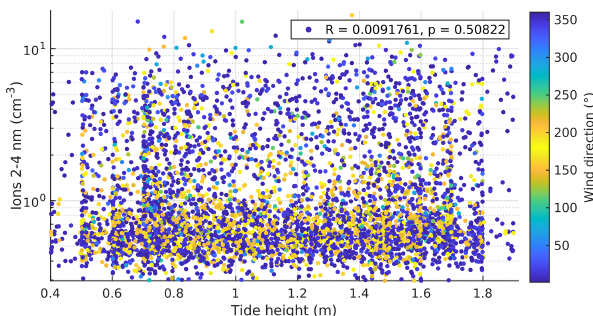
Figure 9. The number concentration of ions as a function of tide height coloured with wind direction. Only data after sunrise and before sunset are